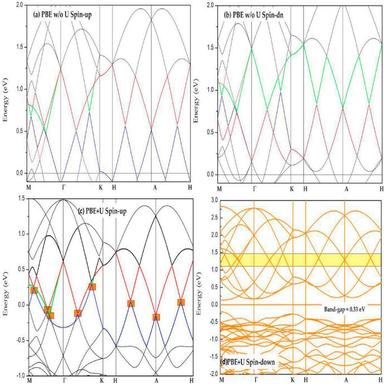
Calculated band structures of rhombohedral R3c-type HoNiO3 in both spin channels: (a) spin up and without U; (b) spin down and without U; (c) spin up with U; and (d) spin down with U.